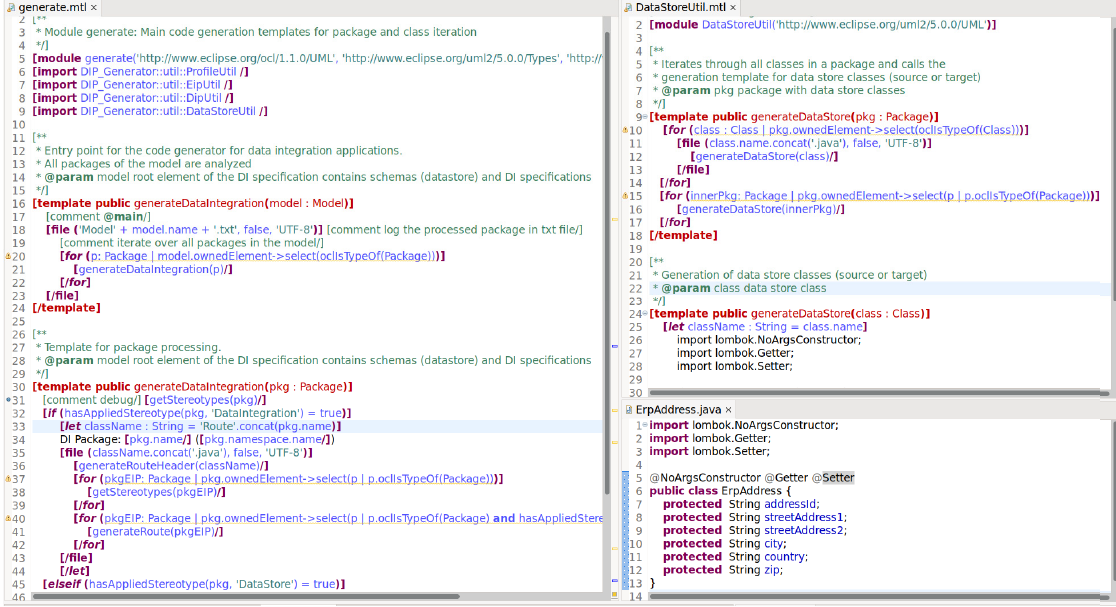
Figure 8. Acceleo code generation templates for data integration application.